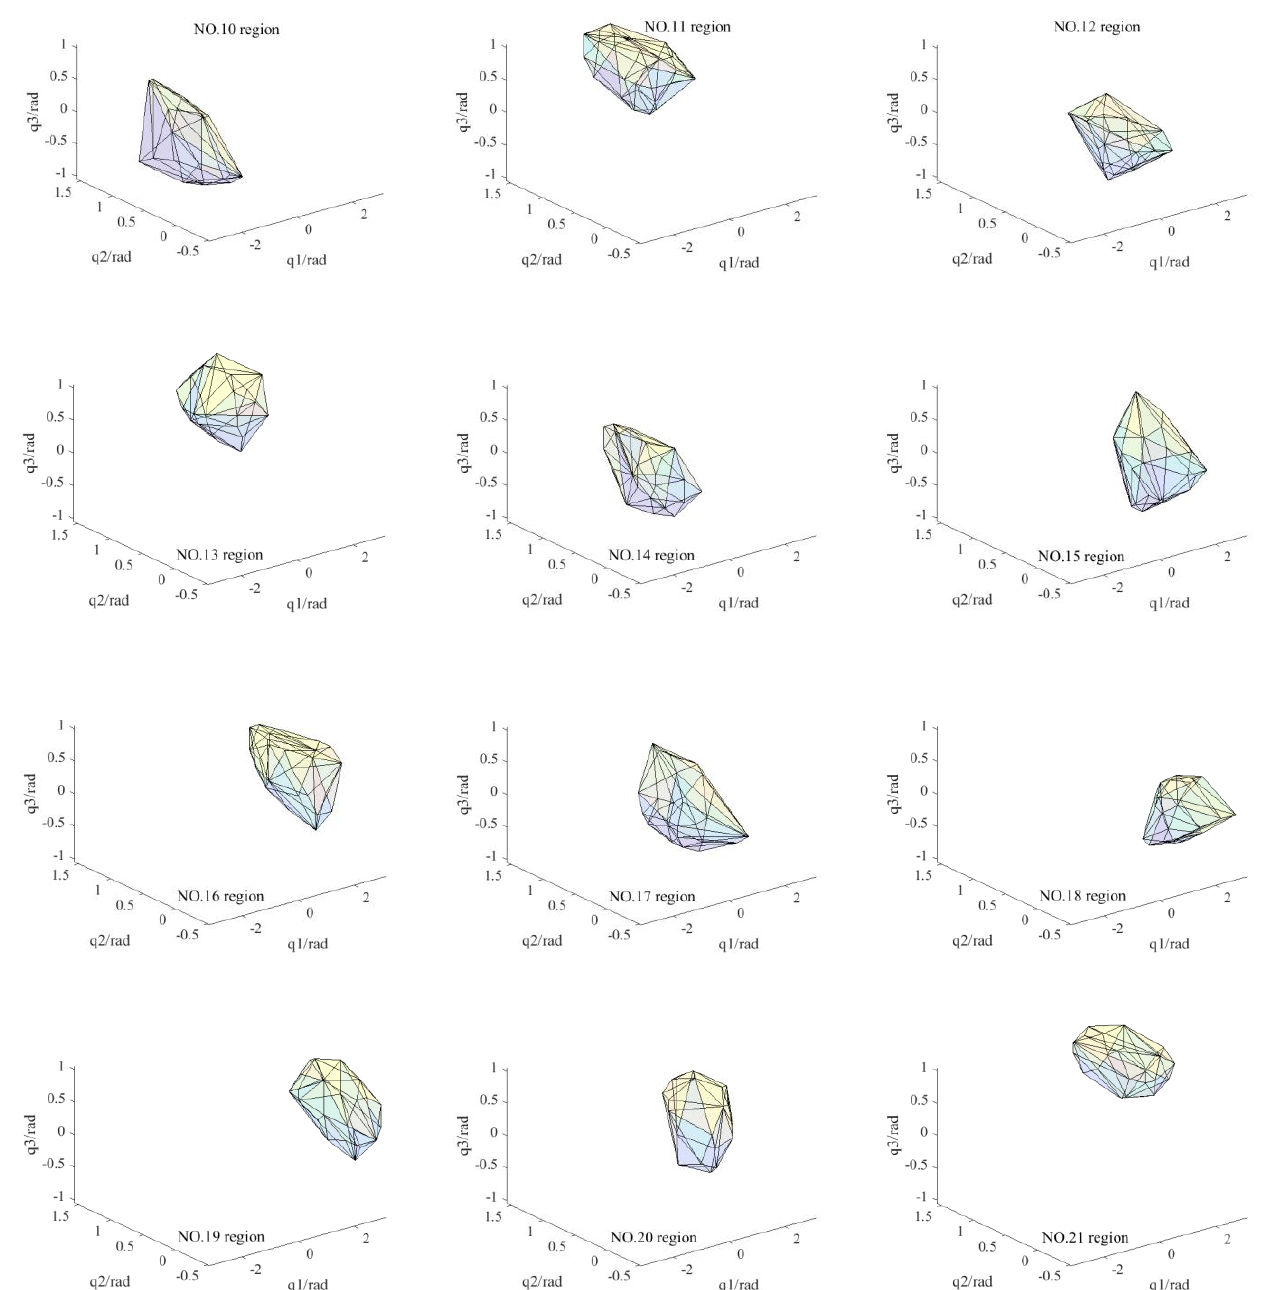
Figure 8. The result of work space division in joint space.